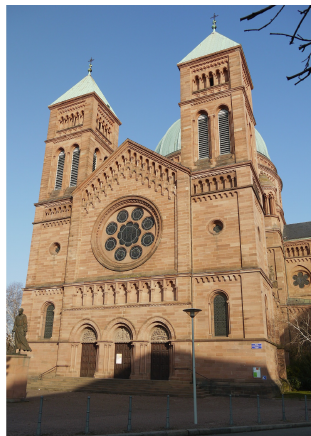
Figure 1. (a) Trimble SX10 scanning total station placed on a tripod and centered on a reference point. (b) View of the rear side of the device.